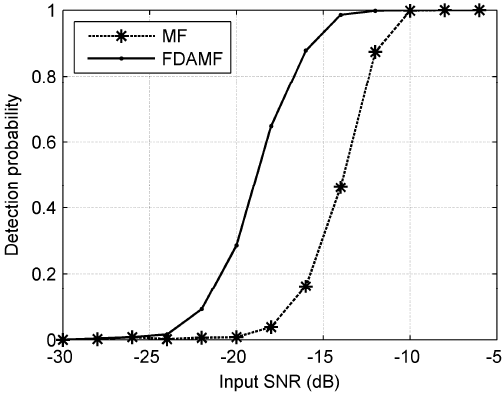
Figure 10. The detection probability curves of the MF and the FDAMF when false-alarm probability is 10 − 3 in AWGN.